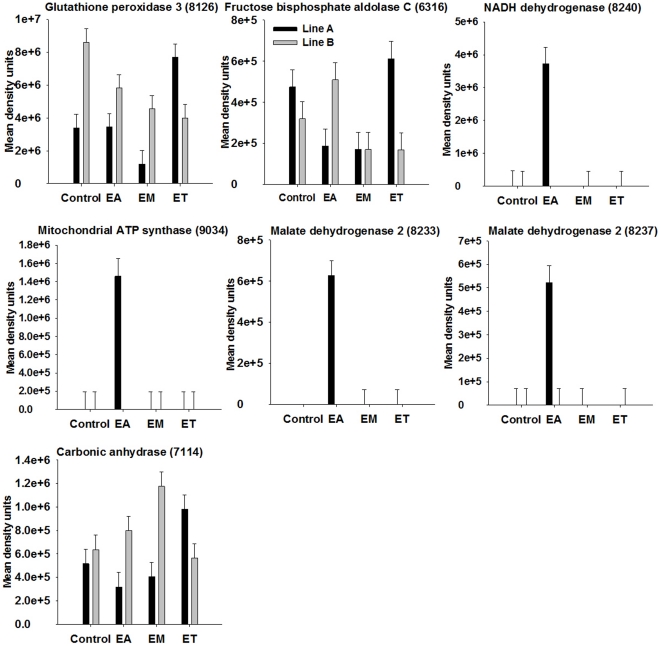
Broiler genetic line×coccidia infection interactions (P<0.001) for metabolic and oxidative-stress related proteins.Line A and B broiler chicks were either not infected (control) or were inoculated with 1 of 3 Eimeria species, E. acervulina (EA), E. maxima (EM) or E. tenella (ET) at 15 d post-hatch. At 21 d (6 d post-infection) serum was harvested from whole blood samples and used for 2D gel electrophoresis followed by MALDI TOF/TOF. Protein density was evaluated by densitometric analysis of spot intensity followed by ANOVA. Values represent mean density units ± SEM (N = 6).